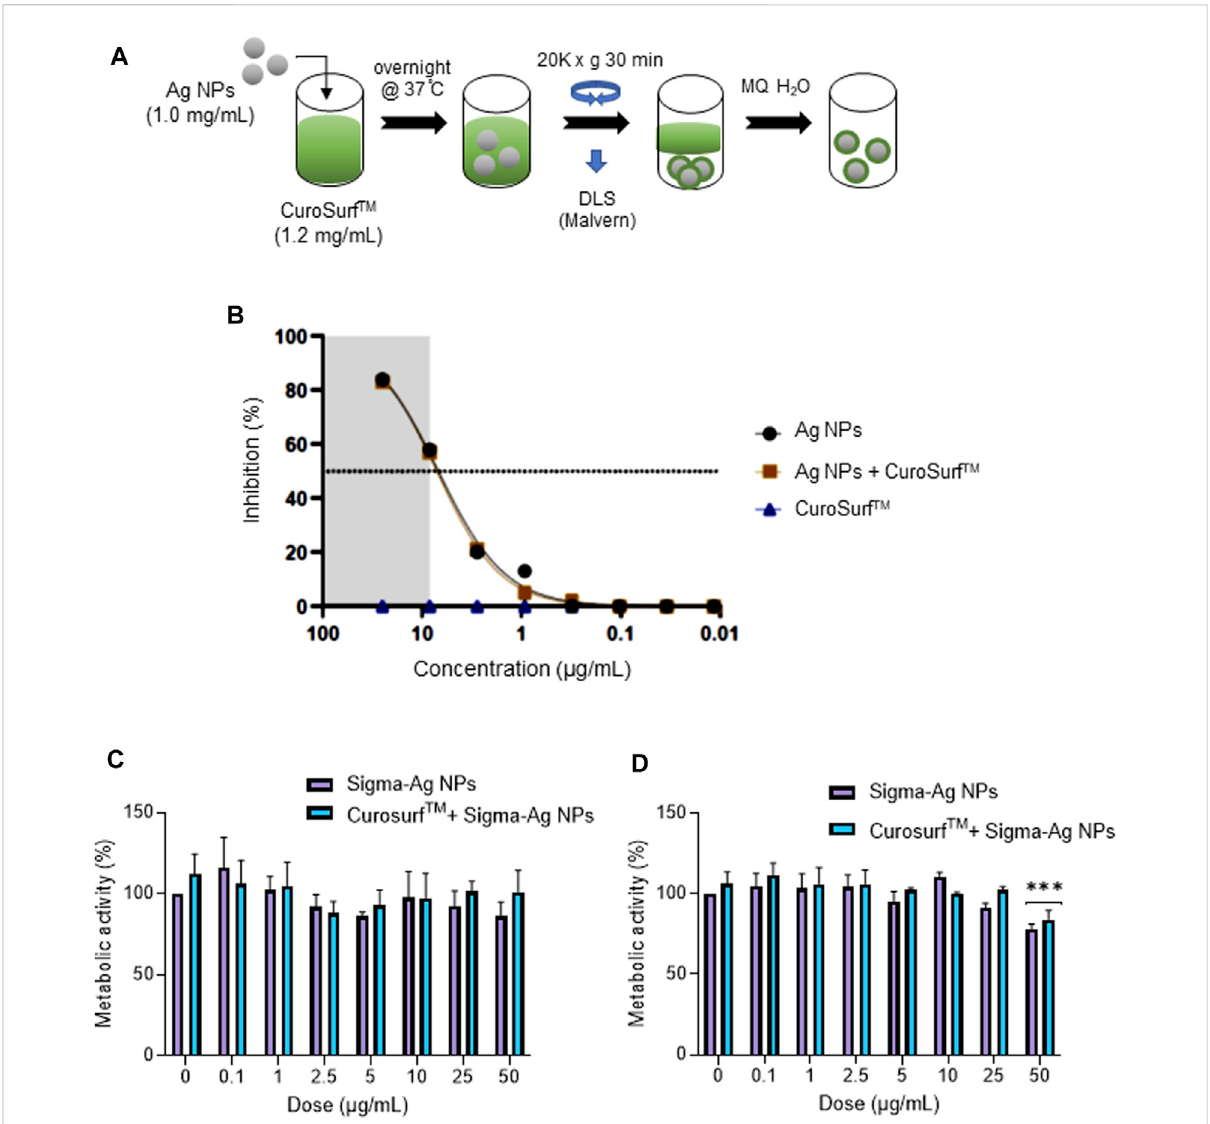
FIGURE 3 Lungsurfactantdoesnotinterferewiththeanti-viralactivityofAgNPs. (A) Schematicrepresentationofthestepsinvolvedinformationofalung surfactant bio-coronaon AgNPs. TheCuroSurf ™ -AgNPscomplexeswereanalyzedwithrespectto hydrodynamicdiameter and ζ -potential ateach washing step (data not shown). (B) Ag-B NPs alone or with a lung surfactant bio-corona showed similar potency in the pseudovirus